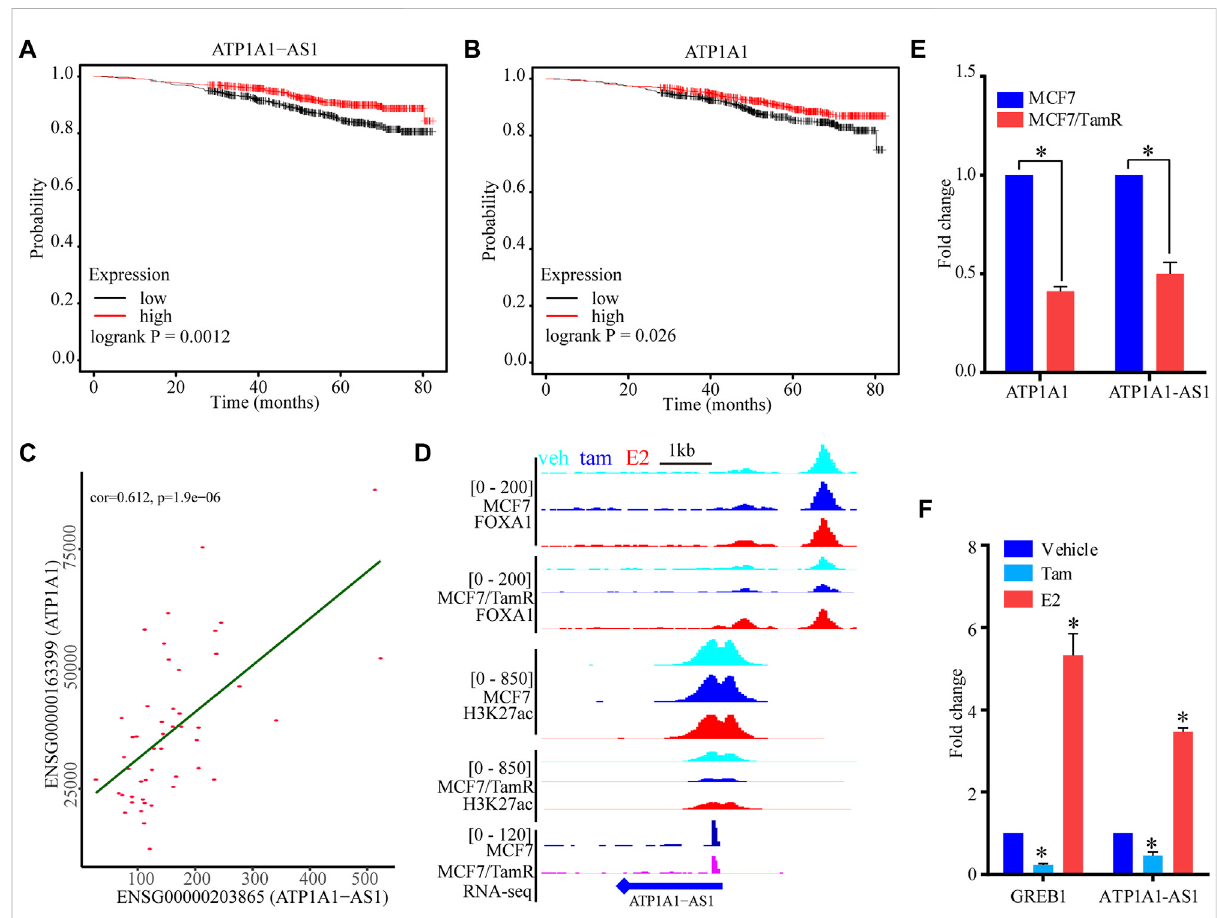
The potential function of ATP1A1-AS1. The KM survival curve of ATP1A1-AS1 (A) and ATP1A1 (B) using the luminal breast cancer treated with endocrine therapy datasets. (C) Coexpression analysis ofATP1A1-AS1 and ATP1A1 using theluminal TCGA-BRCA datasets. (D) The FOXA1 chromatin binding peak distribution of MCF7 and MCF7/TamR cells in the upstream of ATP1A1-AS1, light blue peak, dark blue peak and light red peak respectively represent vehicle (veh), tamoxifen (tam) and estradiol (E2) treatment. (E) Bar plot of the expression level of ATP1A1-AS1 and ATP1A1 in MCF7 and MCF7/TamR cells. (F) Bar plot of the expression level of ATP1A1-AS1 and GREB1 in MCF7/TamR cells upon E2 and tamoxifen treatment. * indicates p <